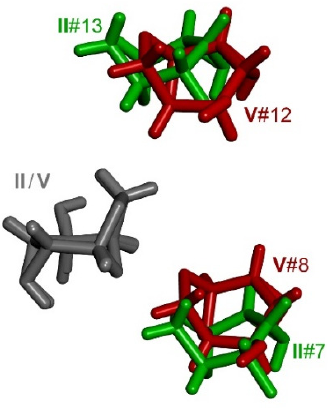
Figure 9. An overlay of similar segments in molecular packing in II (green) and V (red). Parent molecules are depicted in gray.